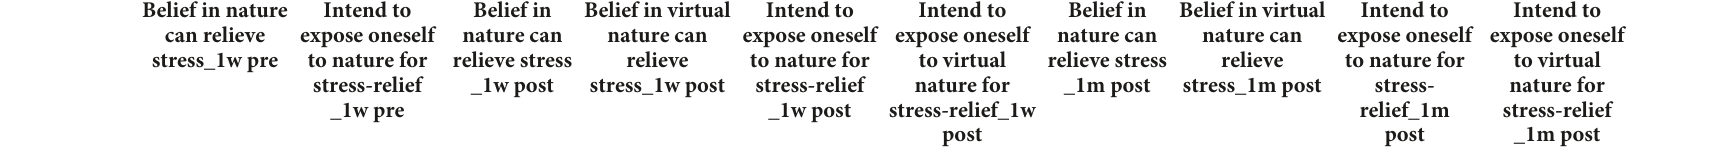
TABLE 3 Correlations of self-constructed items related to motivation ( N =